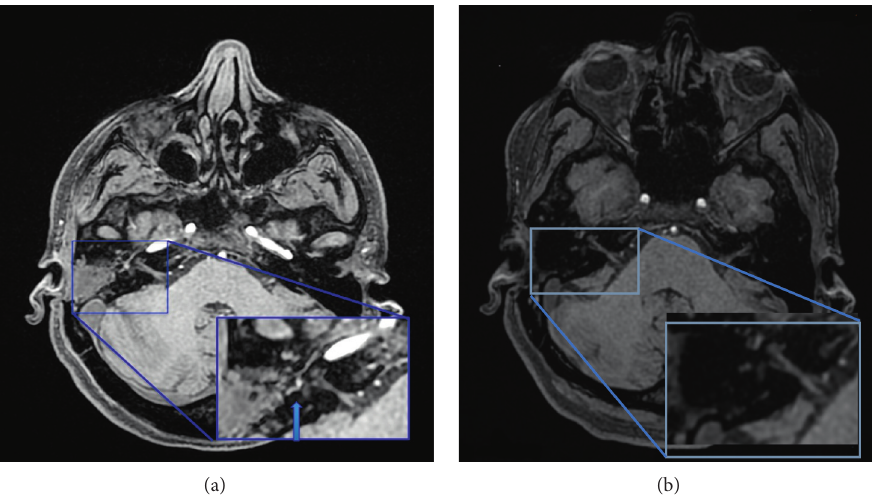
Figure 5: (a) Axial T1 fat-saturated magnetic resonance imaging scan of the middle ear; blue arrow indicated the residual tumor in the middle ear before the canal-wall-down tympanoplasty. (b) Axial T1 fat-saturated magnetic resonance imaging scan of the middle ear after one year from the surgical procedure; the blue rectangle showed the absence of recurrence or persistence of the